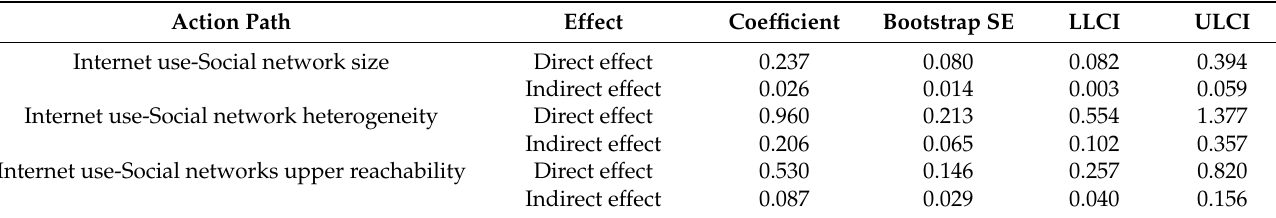
Table 6. Bootstrap mediation test results.